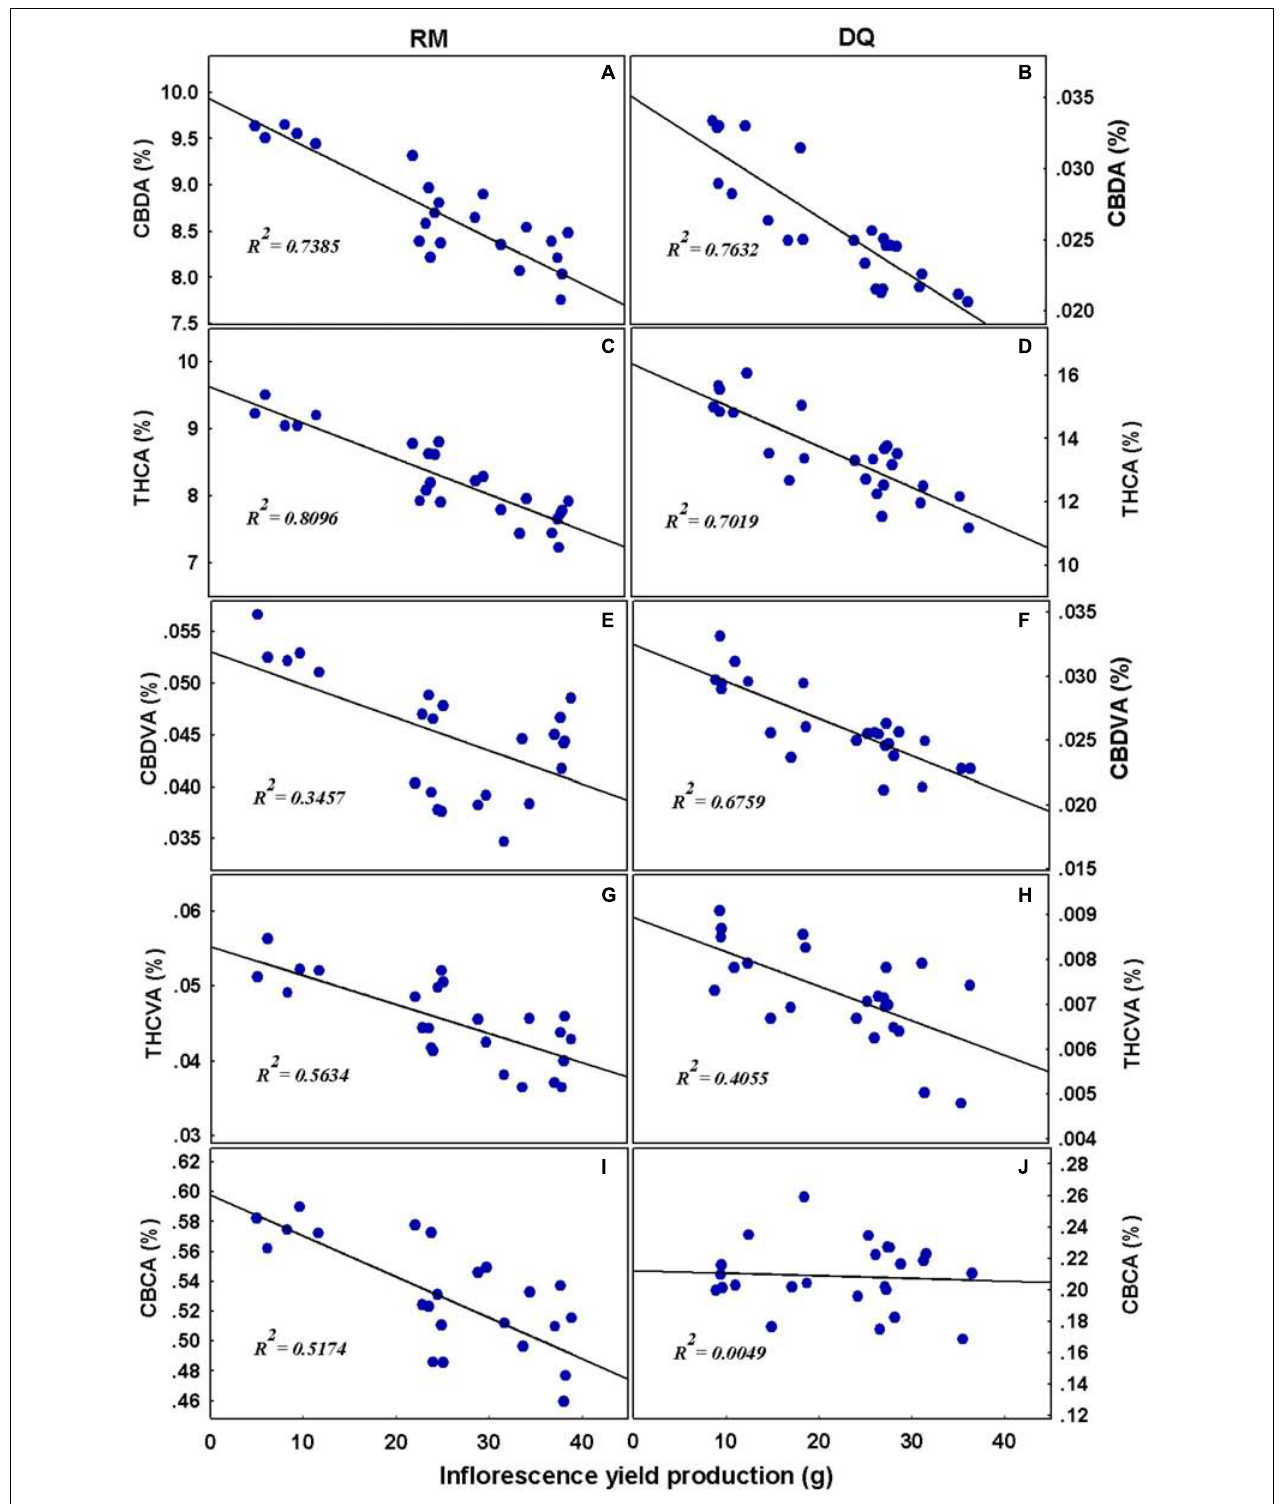
FIGURE 11 | Linear regression analysis. Relationships between cannabinoid concentrations and inflorescence yield per plant. Cannabidiolic acid (A,B) , (cid:49) 9 -tetrahydrocannabinolic acid (C,D) , cannabidivarinic acid (E,F) , (cid:49) 9 -tetrahydrocannabivarinic acid (G,H) , and cannabichromenic acid (I,J) . The continuous line represents the linear fit to the